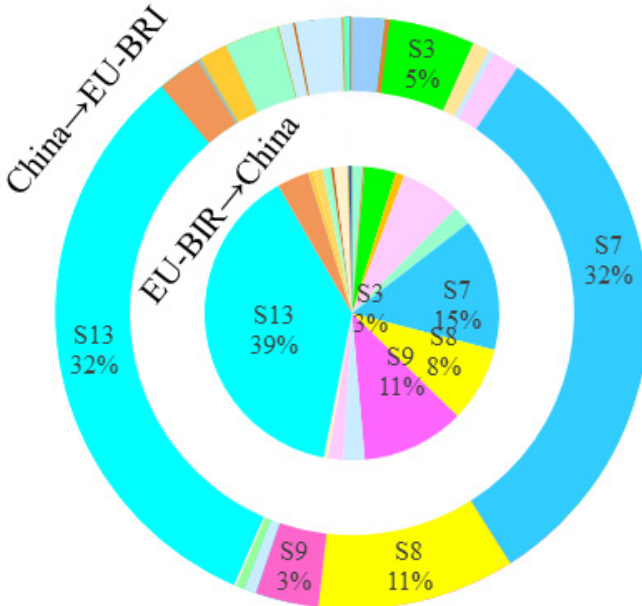
Figure 5. Sectoral CSE between China and EU-BRI.